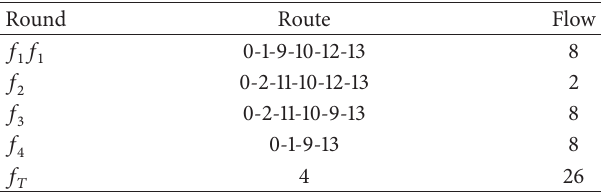
Table 4: Optimal routes of one-to-one evacuation on MFM. Round